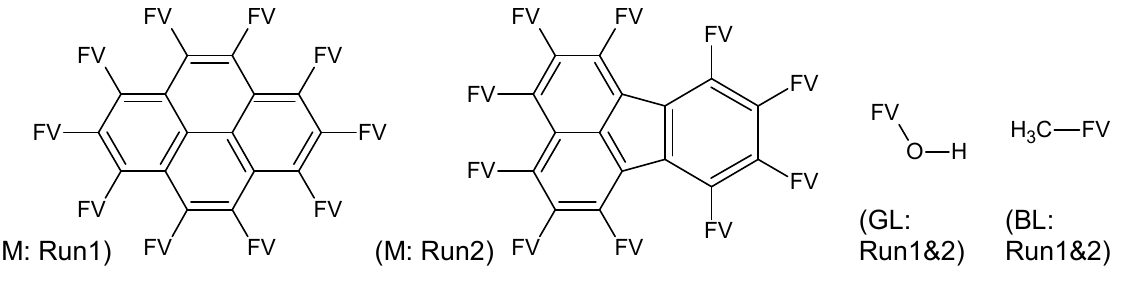
Figure 2. Substructures for Challenge 11. Letters to the bottom left indicate (M) macroatom; (GL) good list (prescribed); (BL) bad list (forbidden) structures. FV = free